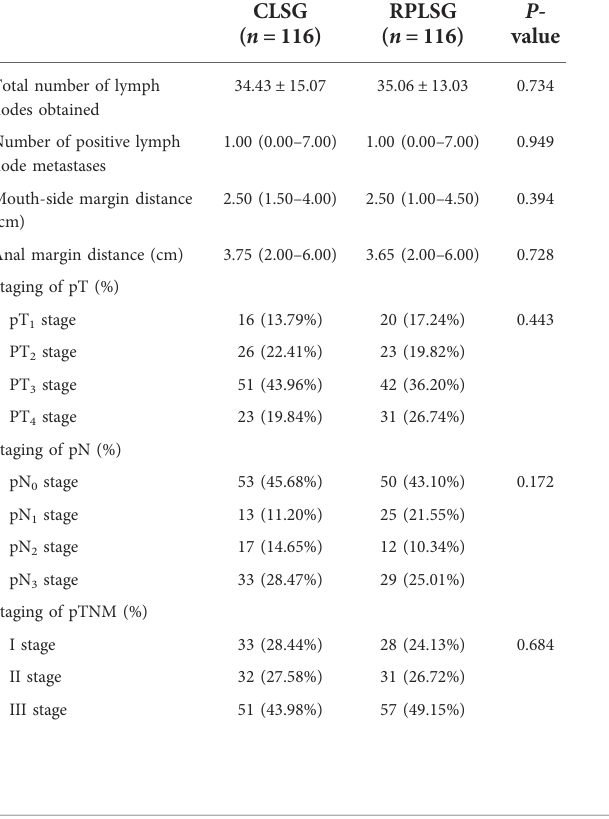
TABLE 3 Postoperative pathological indices.